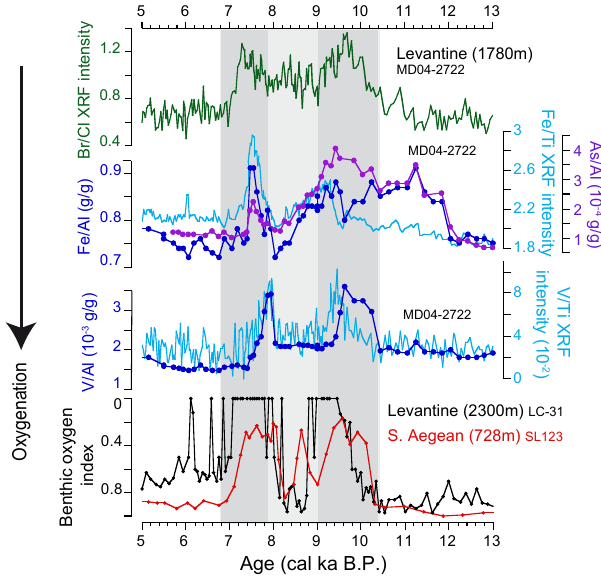
Figure 5. Re-oxygenation in the middle of the S1 interval as in- ferred from the bulk geochemistry (Br / Cl, Fe / Al, Fe / Ti, As / Al, V / Al and V / Ti ratios) in core MD04-2722 and the benthic foraminiferal oxygen index obtained at sites LC-31 and SL123 (Schmiedl et al., 2010) (Fig. 1a, b). Dark and light grey bands indicate the S1 unit (10.4–6.8calkaBP) and the interval of low grayscale values (9.0–7.9calkaBP) in core MD04-2722, respec-